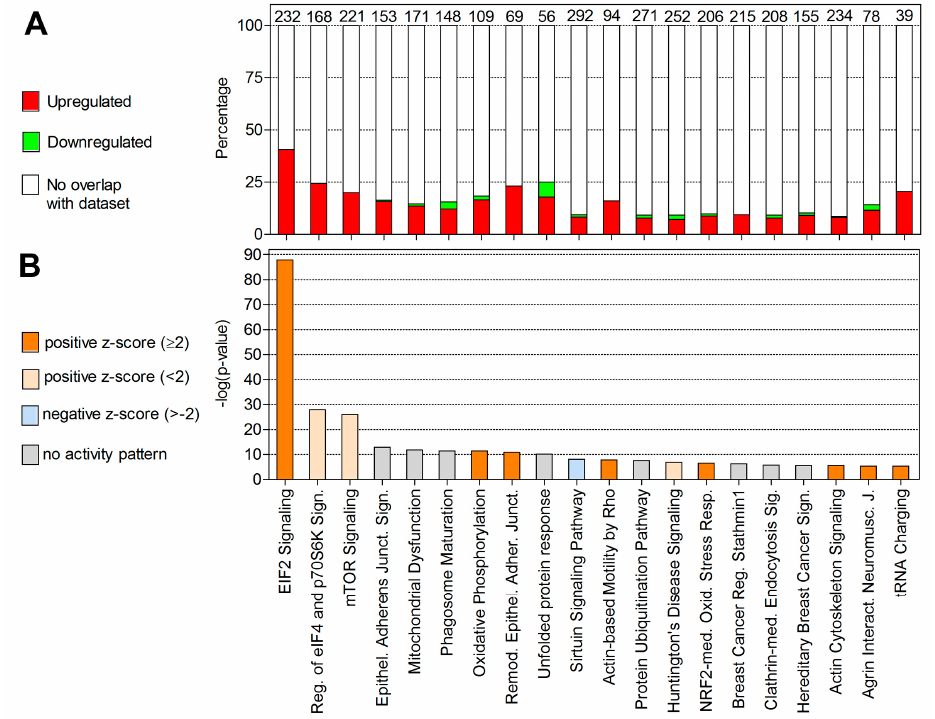
Figure 6. Top 20 most significantly enriched canonical pathways in the infected zooids as identified by Ingenuity Pathway Analysis. ( A ) Percentage of DEGs overlapping with molecules associated to the top 20 most significantly enriched canonical pathways. Colors represent up- (red) and downregulation (green). Numbers on top of the bars represent the total number of molecules associated to each pathway. ( B ) Bars represent the p -values of overlap ( − log) of DEGs in the dataset with known pathway-associated molecules. Colors denote the predicted activation (z-score: ≥ 2) or inhibition (z-score ≤− 2)